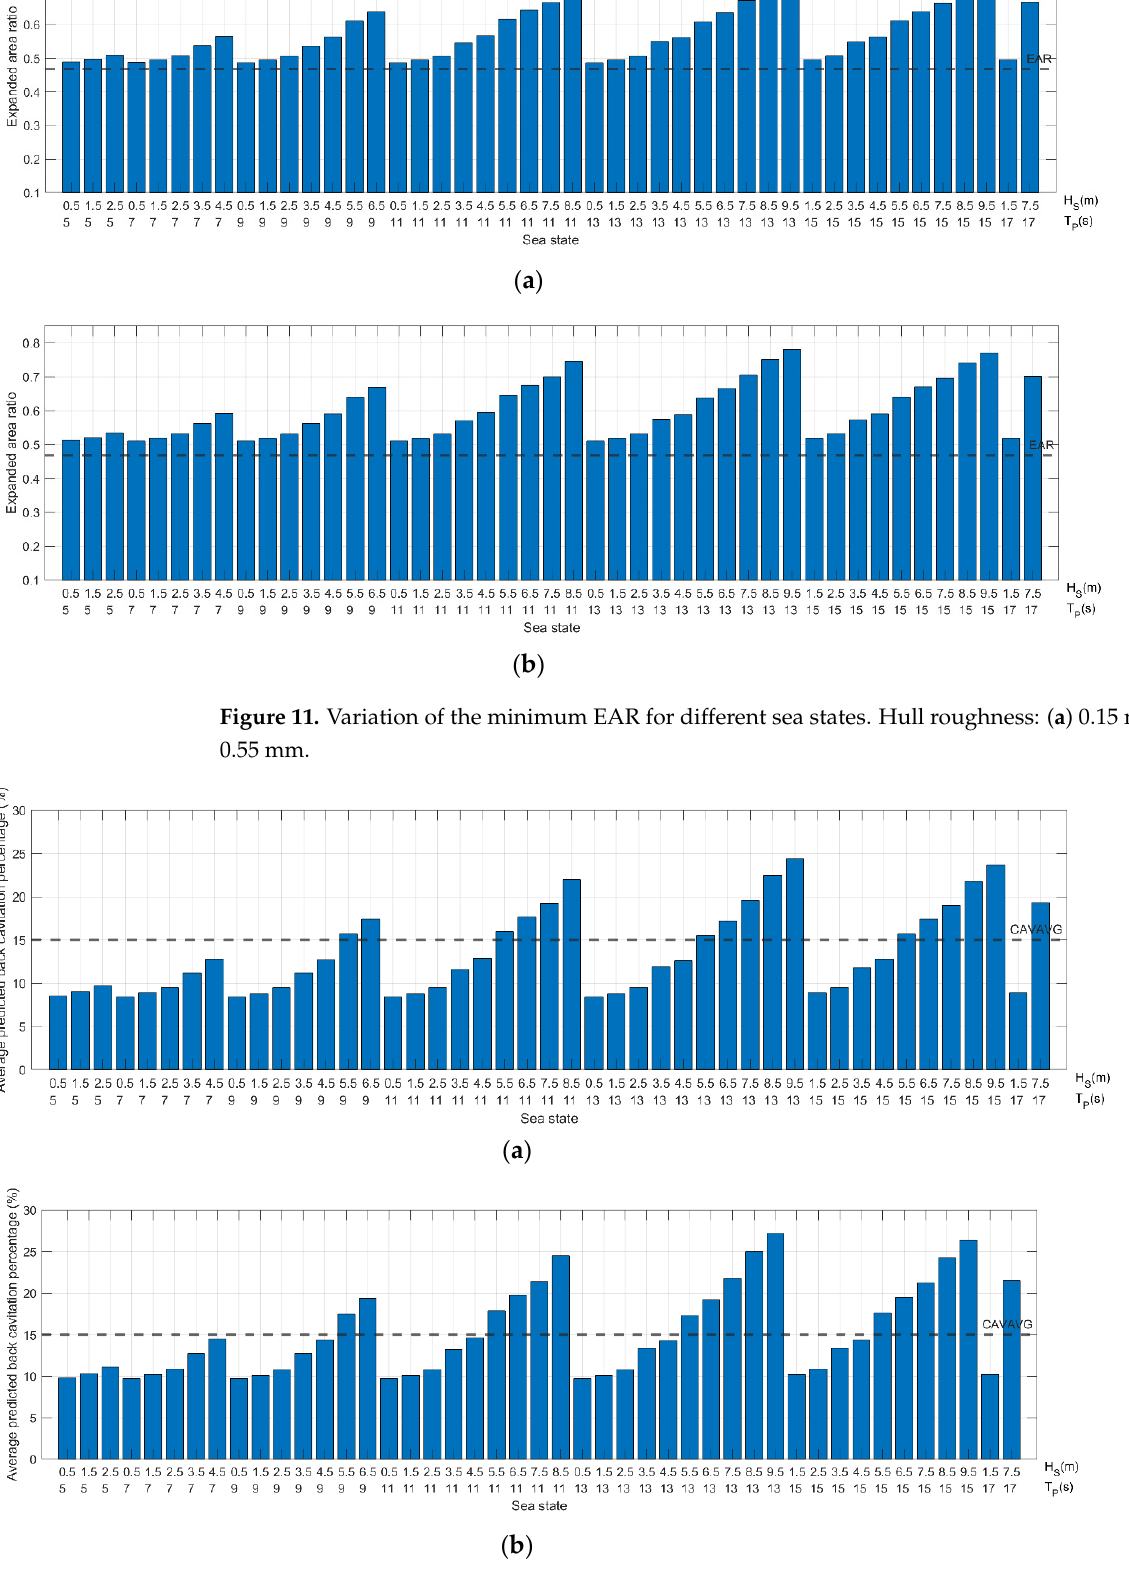
Figure 12. Variation of average predicted back cavitation percentage for different sea states. Hull roughness: ( a ) 0.15 mm; ( b ) 0.55 mm.